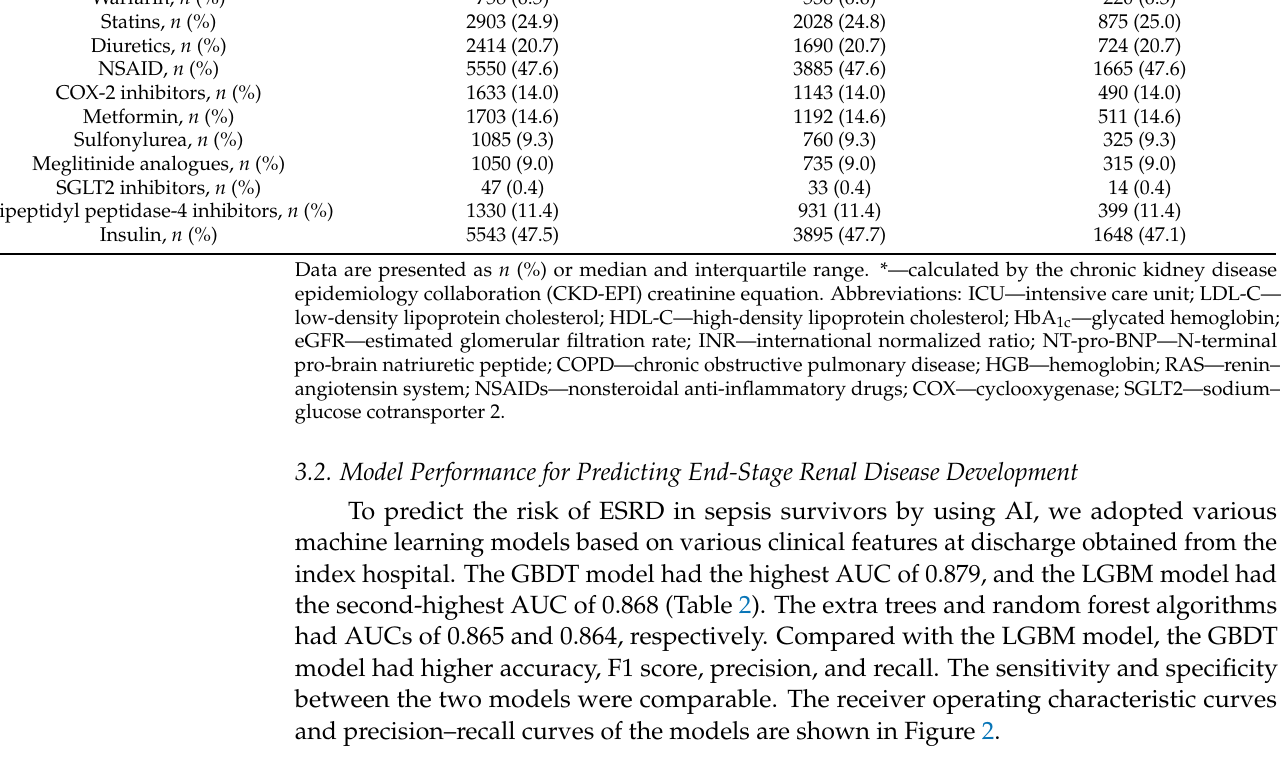
Table 2. Model performance in predicting risk for end-stage renal disease among the sepsis survivors.